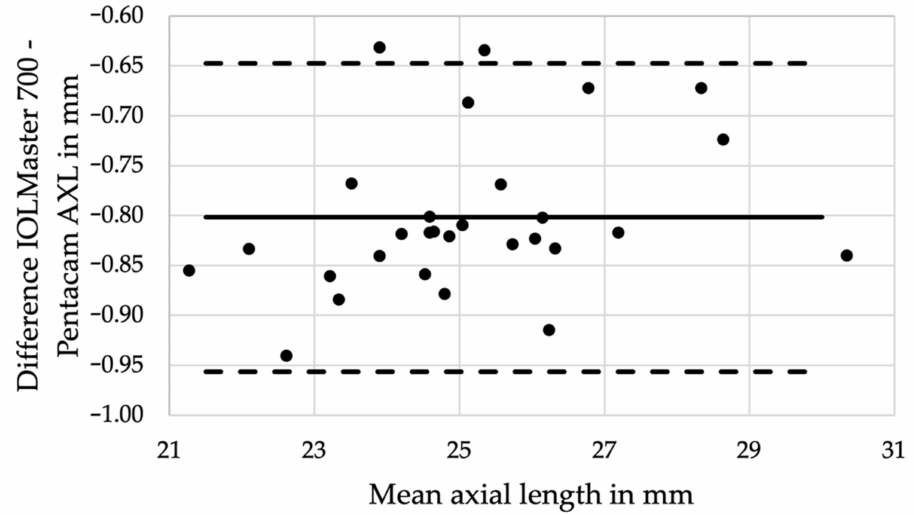
Figure 3. The Bland–Altman analysis confirms good agreement of the axial length measurements between the two devices independent from the axial length with an offset of 0.80 ± 0.08 mm (95% CI: 0.77–0.83 mm), p <